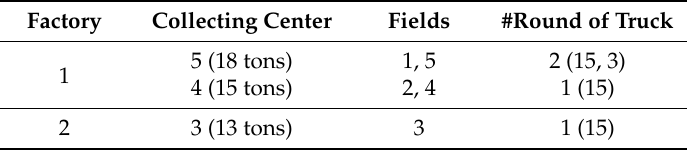
Table 3. Assignment results of fields, collecting centers, and